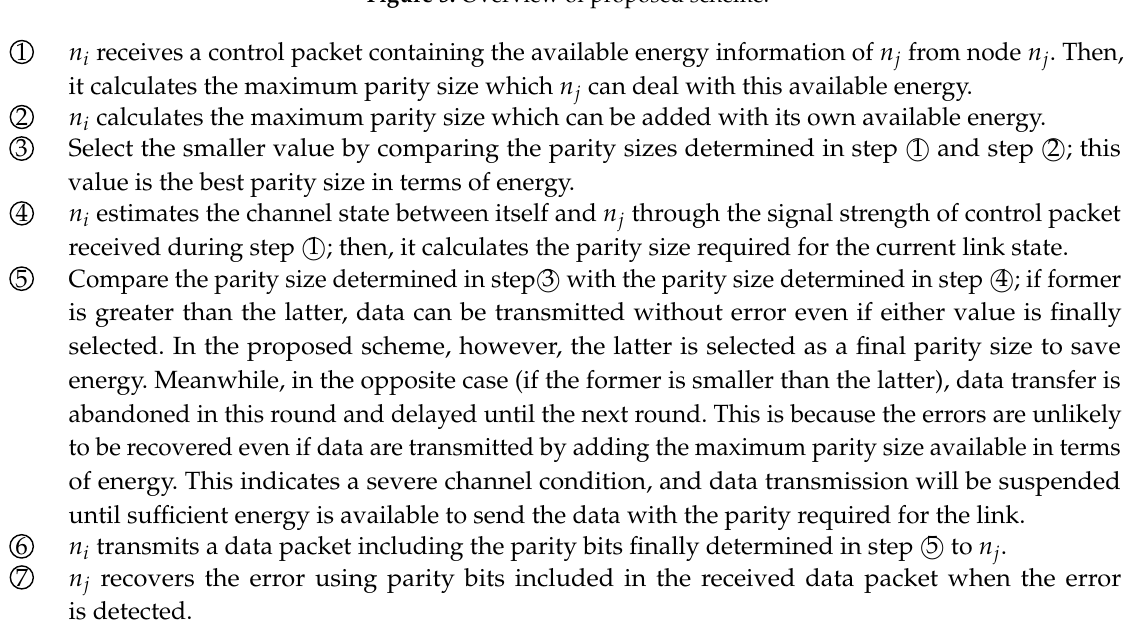
Figure 5. Overview of proposed